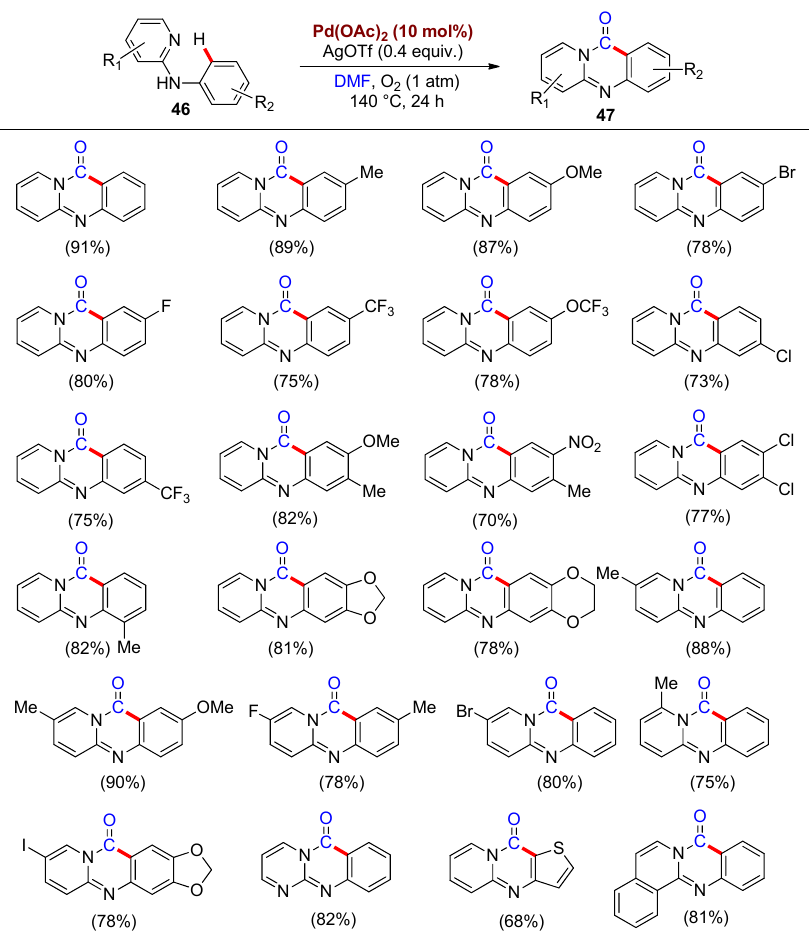
Scheme 18. Synergistic Pd/Ag-catalyzed carbonylative cyclization of N -arylpyridin-2-amines 46 using